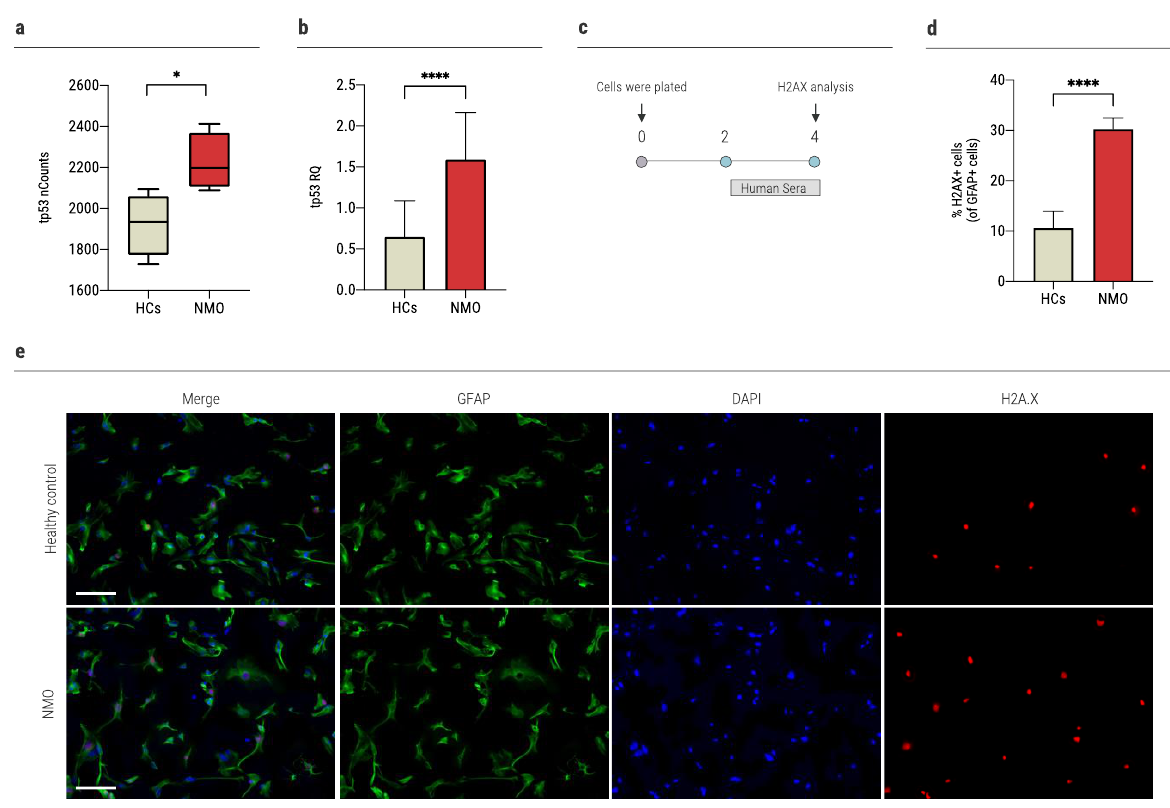
Figure 3. Sera of AQP4+NMO patients increase DNA damage response in astrocytes. ( a ) The expression of tp53 increased significantly in the human astrocytes cultured with sera of NMO patients (2224.3 ± 139.3, n = 4) compared to the HCs (1923.2 ± 150.9, n = 4), as was determined with NanoString nCounter technology, ( b ) the expression of tp53 increased significantly in the astrocytes cultured with sera of NMO patients (1.6 ± 0.6, n = 15) vs. 0.64 ± 0.4 ( n = 12) of the HCs, as was determined using rt-QPCR, ( c ) time-course experiments of H2AX expression. Mouse primary astrocytes were cultured with human sera (20% of media) for 48 h, followed by evaluation of nuclear H2AX expression using immunofluorescence staining, ( d ) nuclear expression of H2AX was determined after culture of 48 h: HCs: 10.6 ± 3.4%; NMO: 30.3 ± 2.2%. Data are means ± SD ( n = 9 for each group), ( e ) representative immunofluorescence analysis of primary astrocytes cultured with sera from seropositive NMO patient or HC for 48 h (scale bar = 60 µ m). Each assay was repeated independently at least three times. Significance was determined by unpaired two-tailed student’s t -test ( p * ≤ 0.05, **** ≤ 0.0001,). Error bars in all graphs represent standard